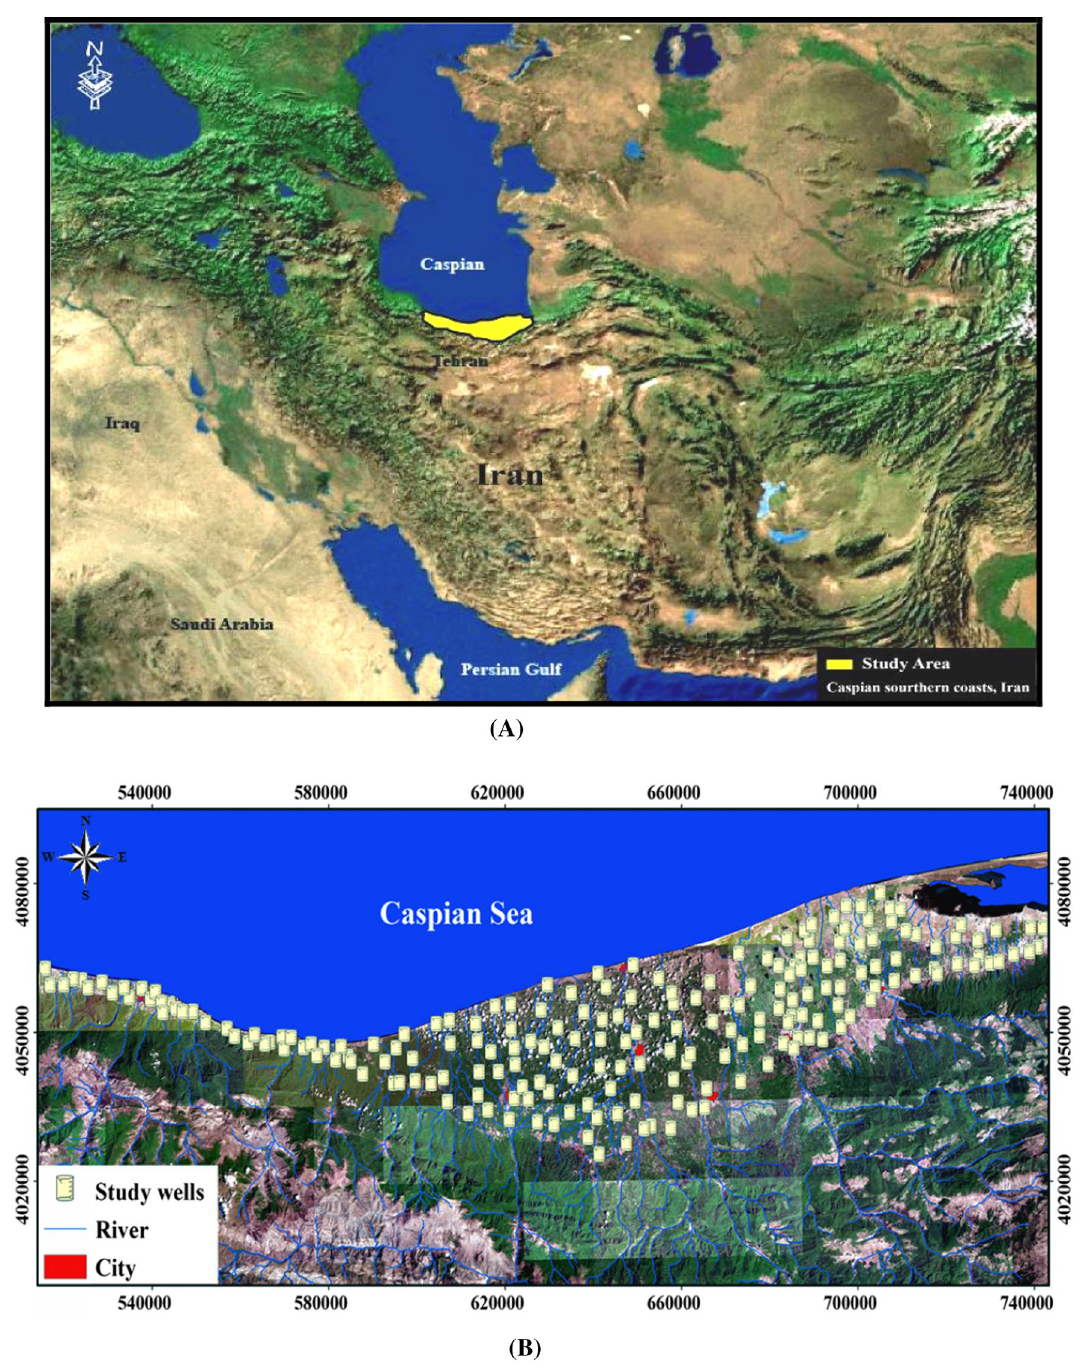
Fig. 1 Location of the study area ( a ) and the studied wells ( b